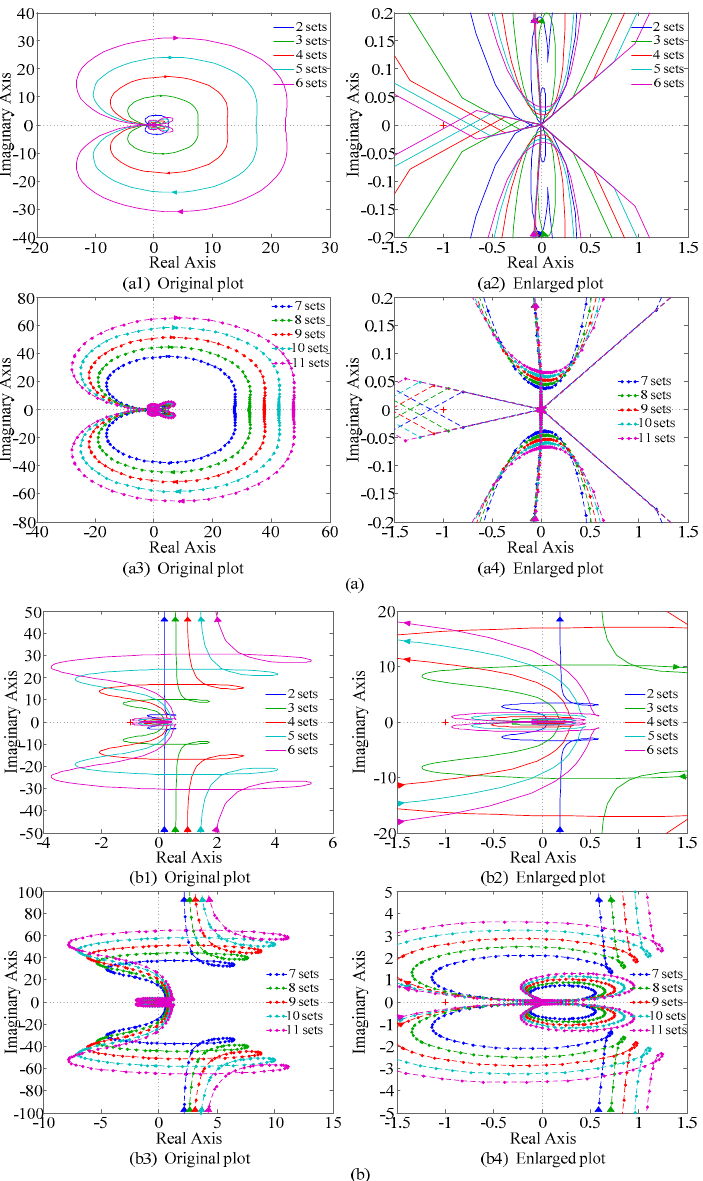
Figure 11. Nyquist diagrams of impedance ratio K for the paralleled multi-inverter system. ( a ) Case I; ( b ) Case II.